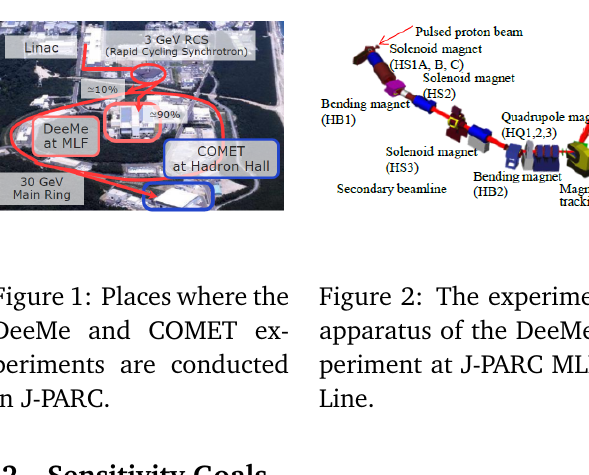
Figure 3: Simulated mo- mentum spectra of electrons at the